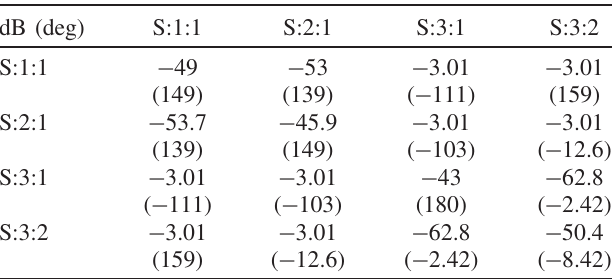
TABLE II. Scattering matrix of polarizer from HFSS.